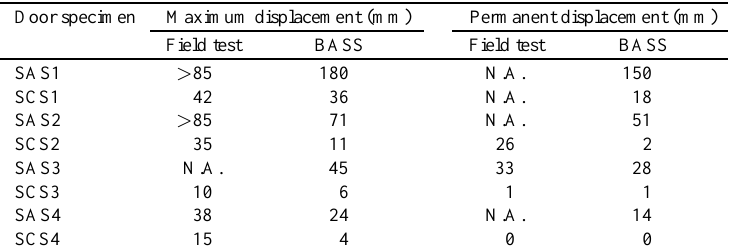
Table 4 Maximum and permanent displacements at centre of blast door